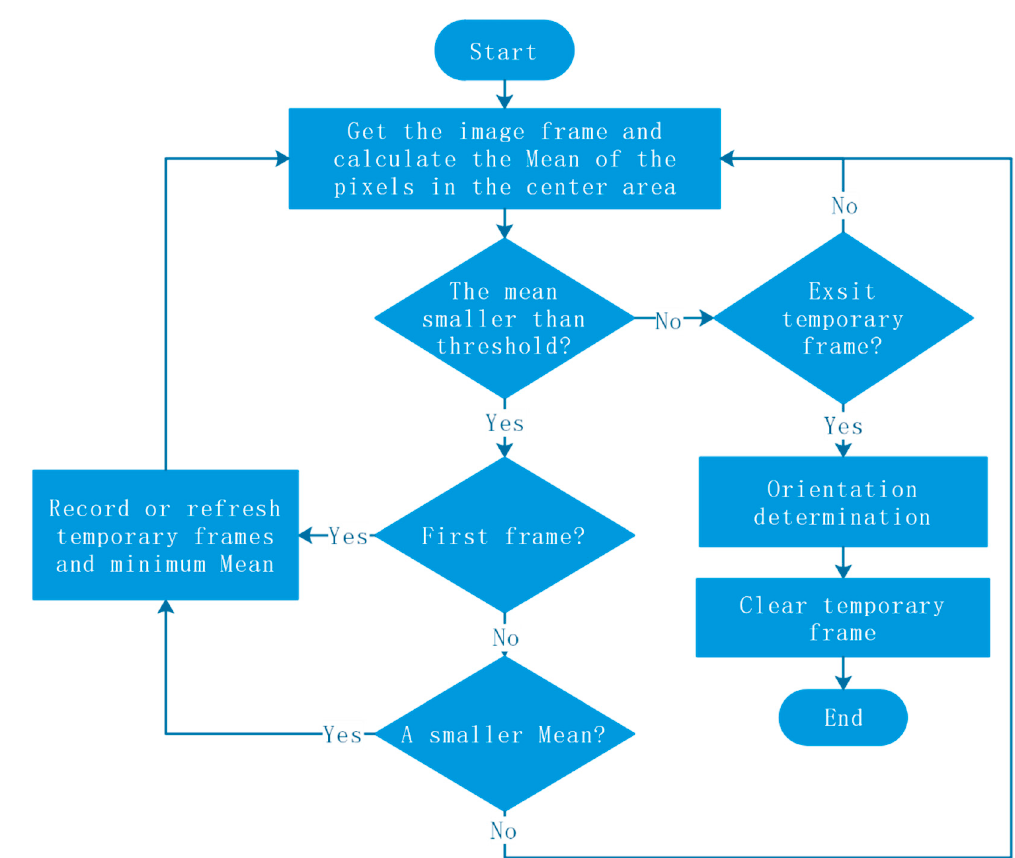
Figure 18. Frame retrieval flow chart.